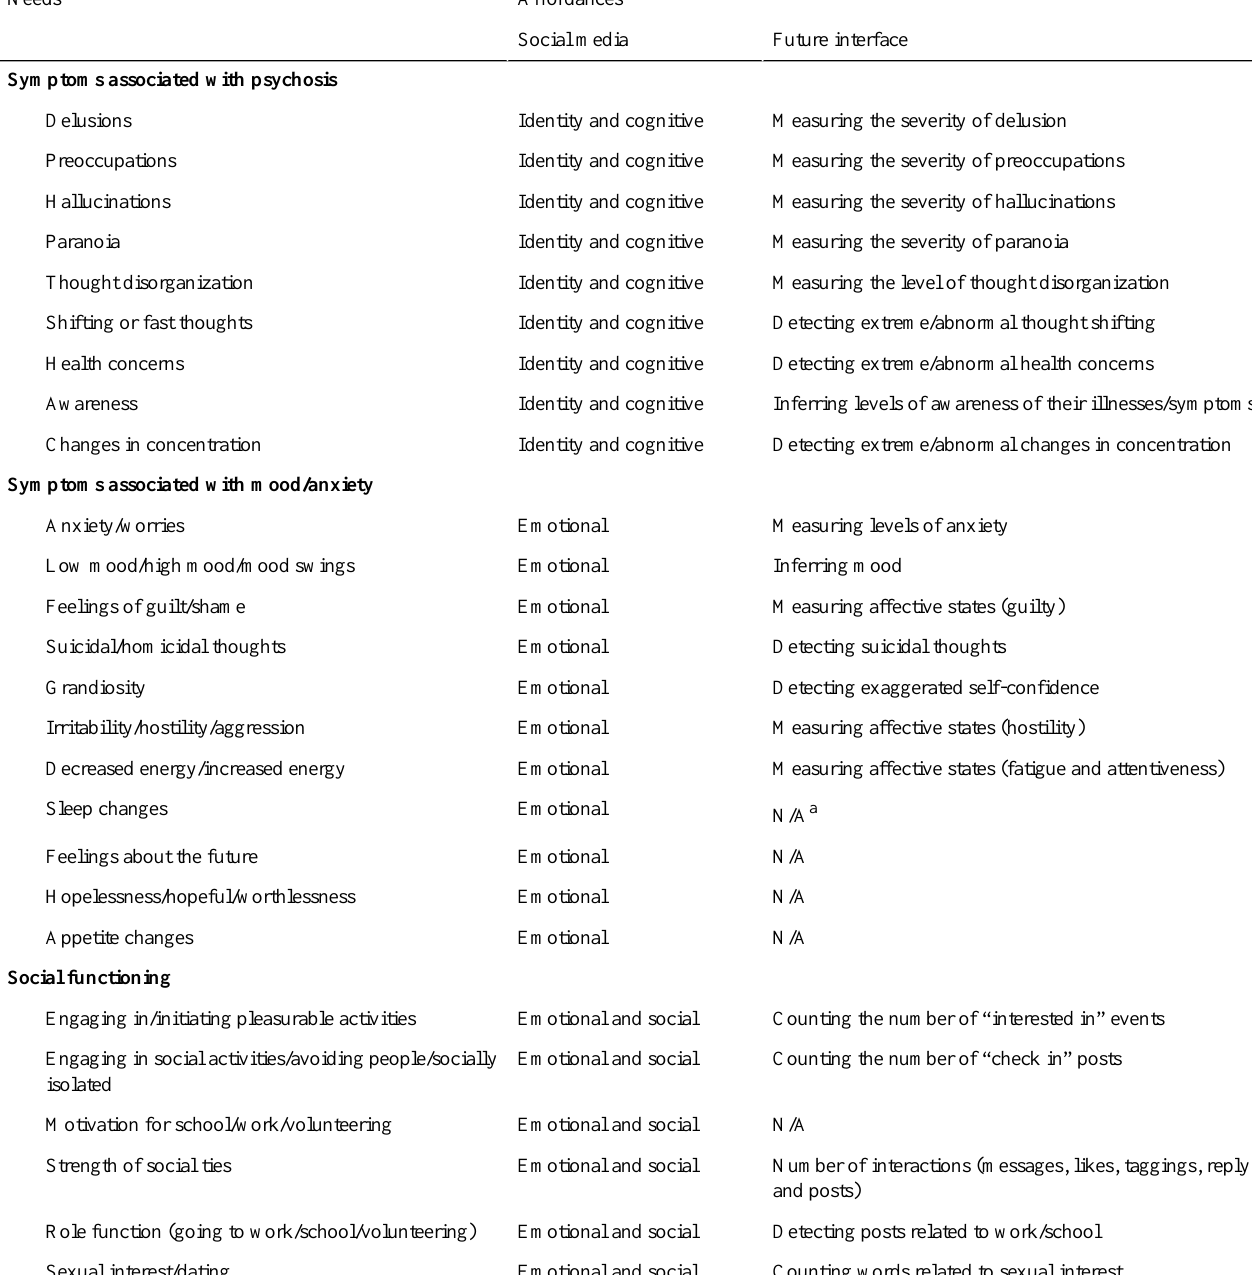
Table 3. The second needs-affordances